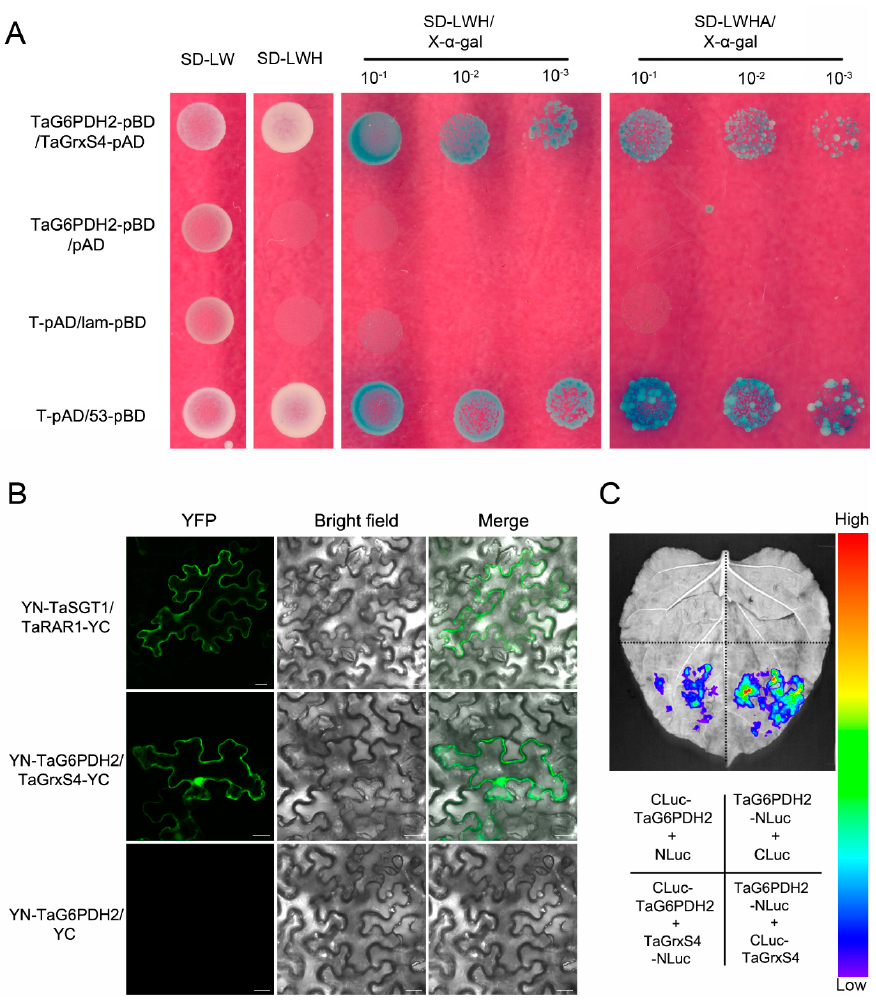
Figure 6. TaG6PDH2 interacts with TaGrxS4. ( A ) TaG6PDH2 interacts with TaGrxS4 in the Y2H system. Yeast strain AH109, containing the indicated pairs of plasmids, was normally grown on selective media SD/ − LW, SD/ − LWH, or SD/ − LWHA containing 20 mg/mL X −α− gal. The growth conditions of the plates were observed and photographed 3 days after inoculation. SD, synthetic dropout. W, Tryptophan. L, Leucine. H, Histidine. A, Adenine. ( B ) BiFC analysis of the interaction of TaG6PDH2 and TaGrxS4. Co − infiltration of YN − TaSGT1 and TaRAR1 − YC was used as a positive control (upper); Co − infiltration of YN-TaG6PDH2 and TaGrxS4 − YC (middle); co-infiltration of YN − TaG6PDH2 and YC was used as a negative control (bottom). BF (bright-field) and YFP fluorescence (green) images were obtained using an Olympus FV3000 confocal microscope. Scale bars, 20 μ m. ( C ) Luciferase complementation assay to verify the interaction of TaG6PDH2 and TaGrxS4. Co-expression of the indicated combinations mediated by agrobacterium in N. benthamiana leaves. All assays were repeated independently at least three times with comparable results.